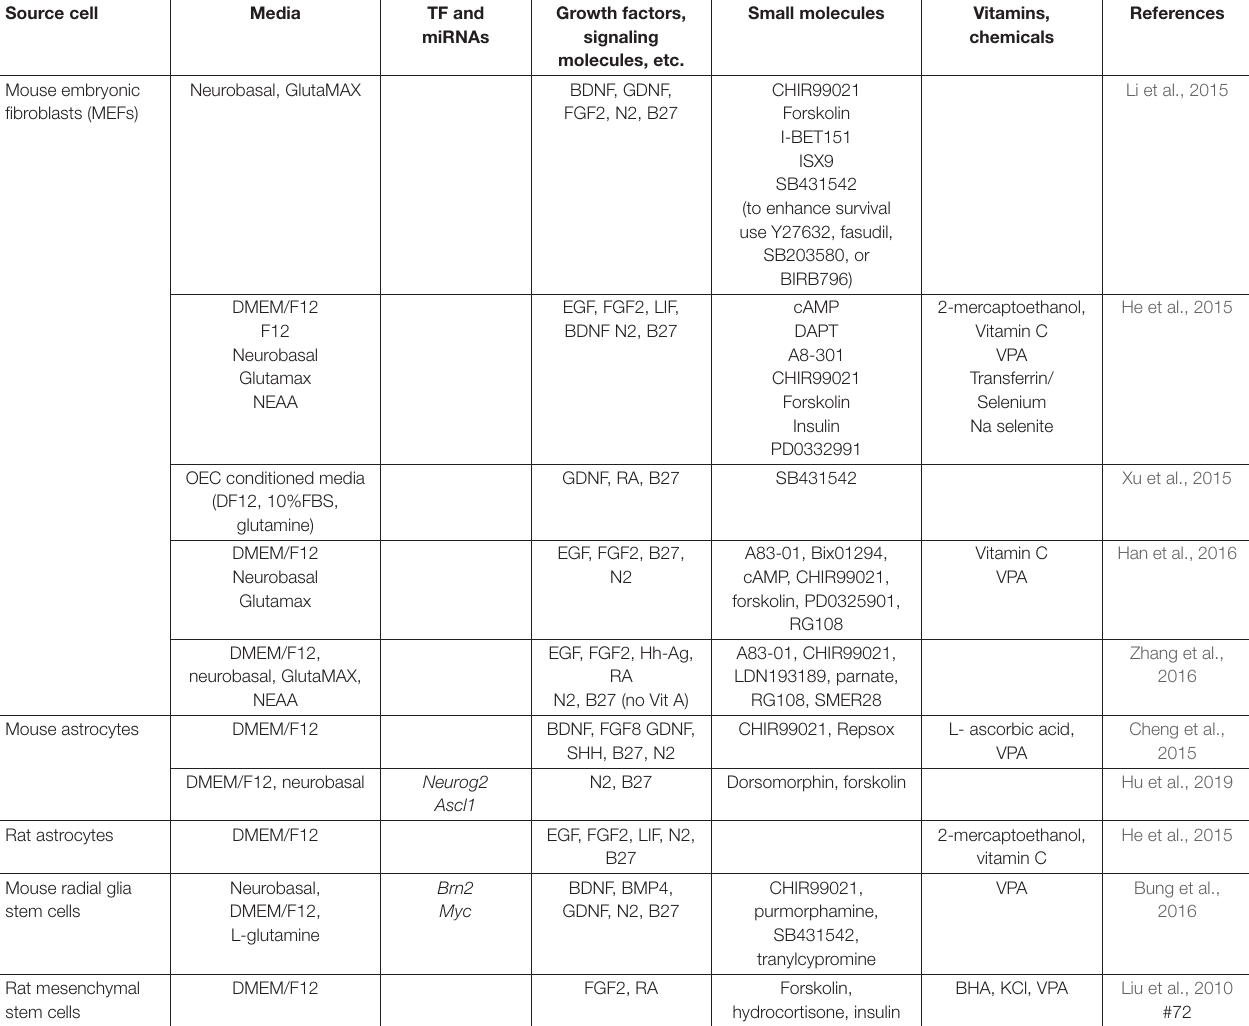
TABLE 2 | Small molecules used in iN lineage conversion strategies in rodent